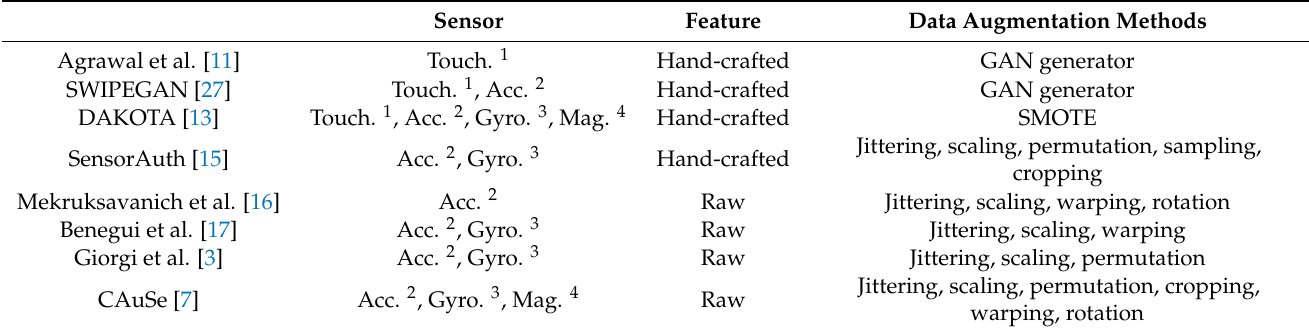
Table 2. Data augmentation methods applied in mobile-based